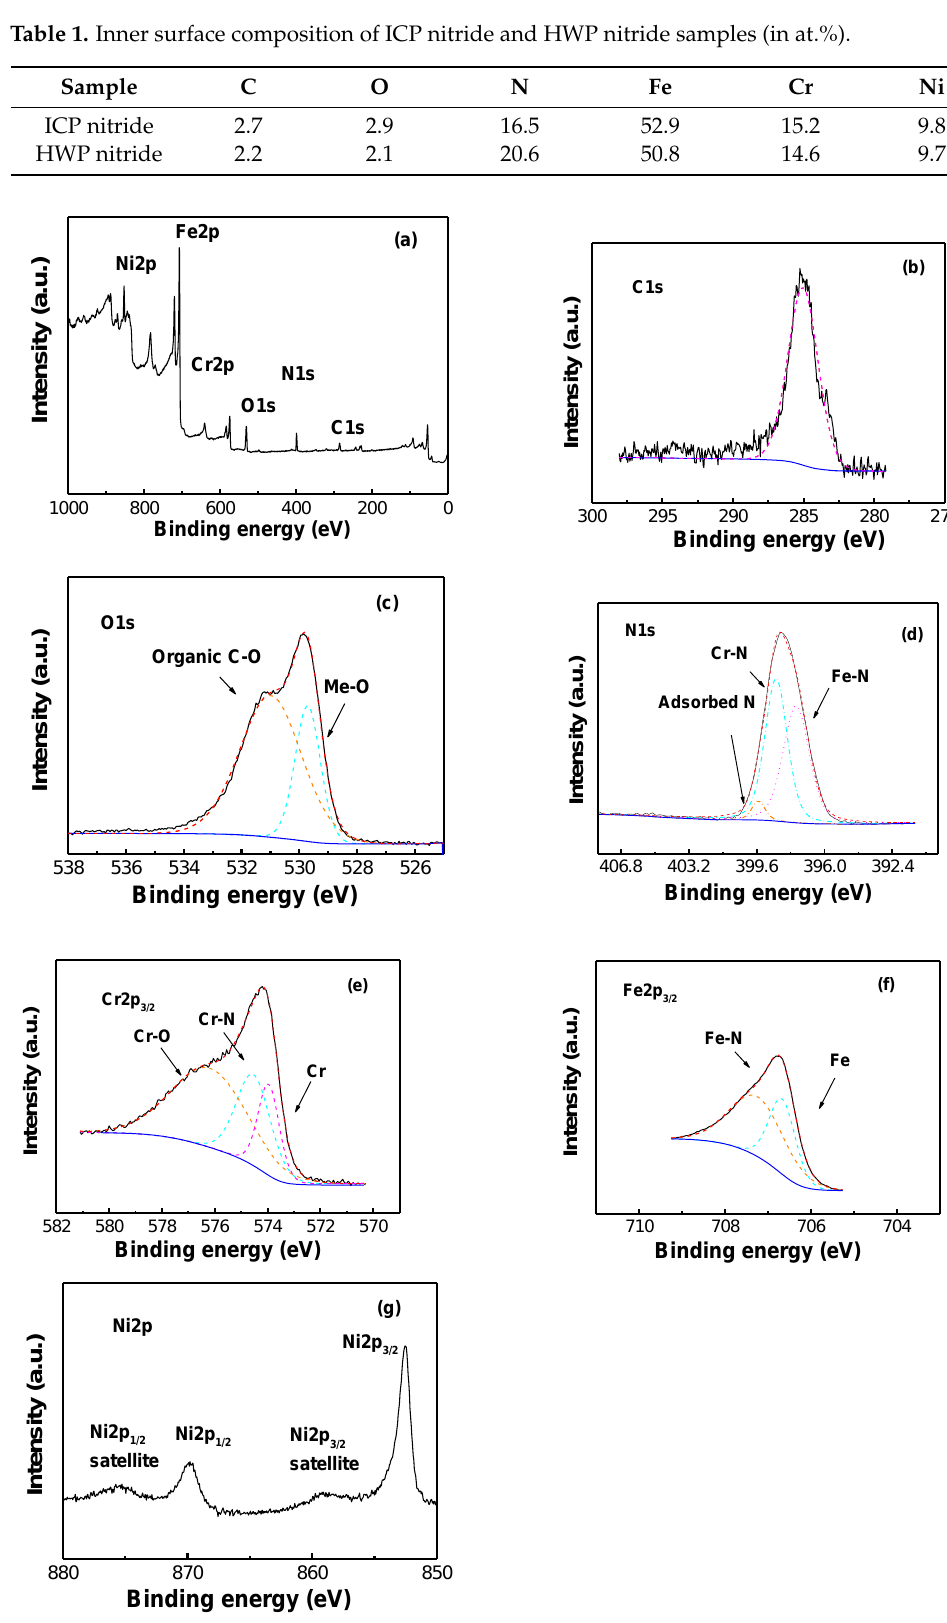
Figure 5. X-ray photoelectron spectroscopy spectra of Sample S3: ( a ) survey spectra, ( b ) C1s, ( c ) O1s, ( d ) N1s, ( e ) Cr2p 3/2 , ( f ) Fe2p 3/2 , ( g ) Table 1. Inner surface composition of ICP nitride and HWP nitride samples (in at.%).